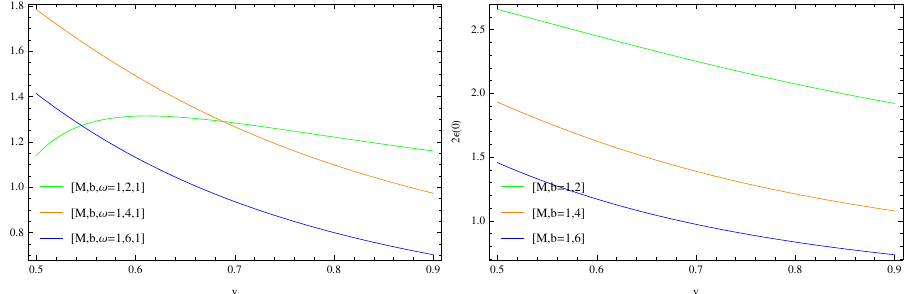
Figure 8. ( left ) Total deflection for a specific value of φ , say, φ = 0, i.e., 2 (cid:101) ( 0 ) is shown against v for different values of the impact parameter b . ( right ) Total deflection 2 (cid:101) ( 0 ) at φ = 0 is shown against v for different values of the impact parameter b , for Schwarzschild